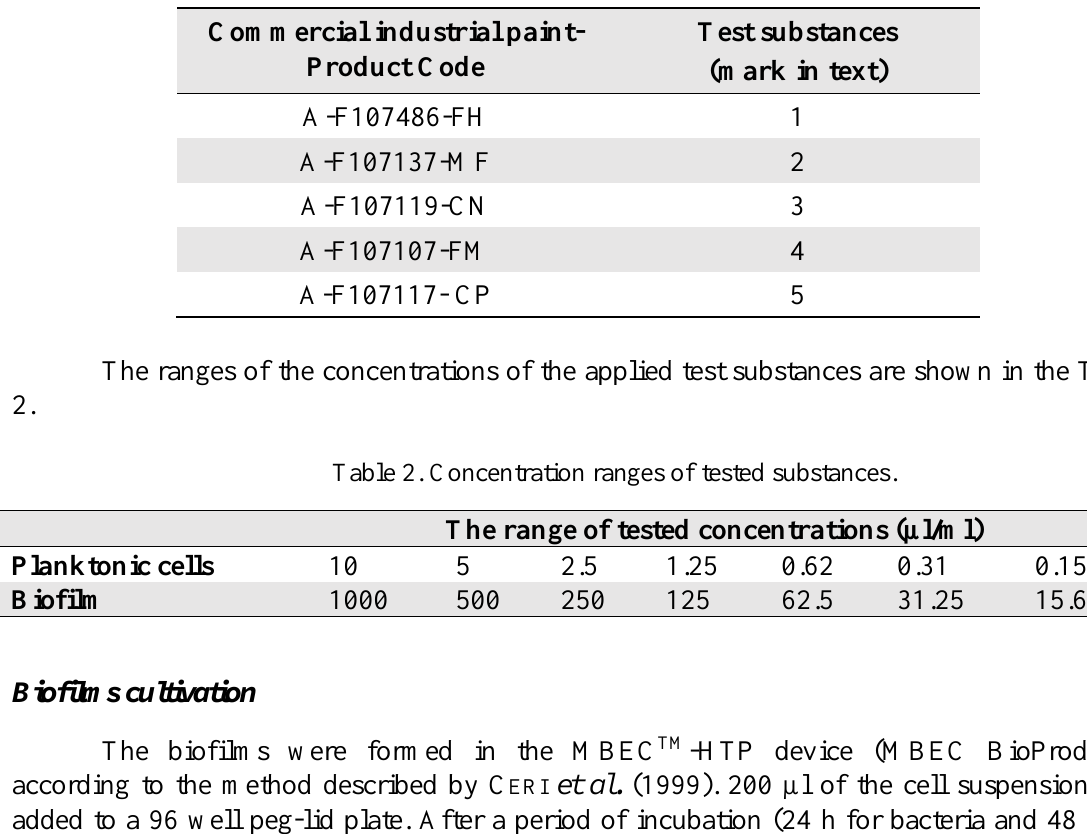
Table 1. Test substances used as antimicrobial agents.